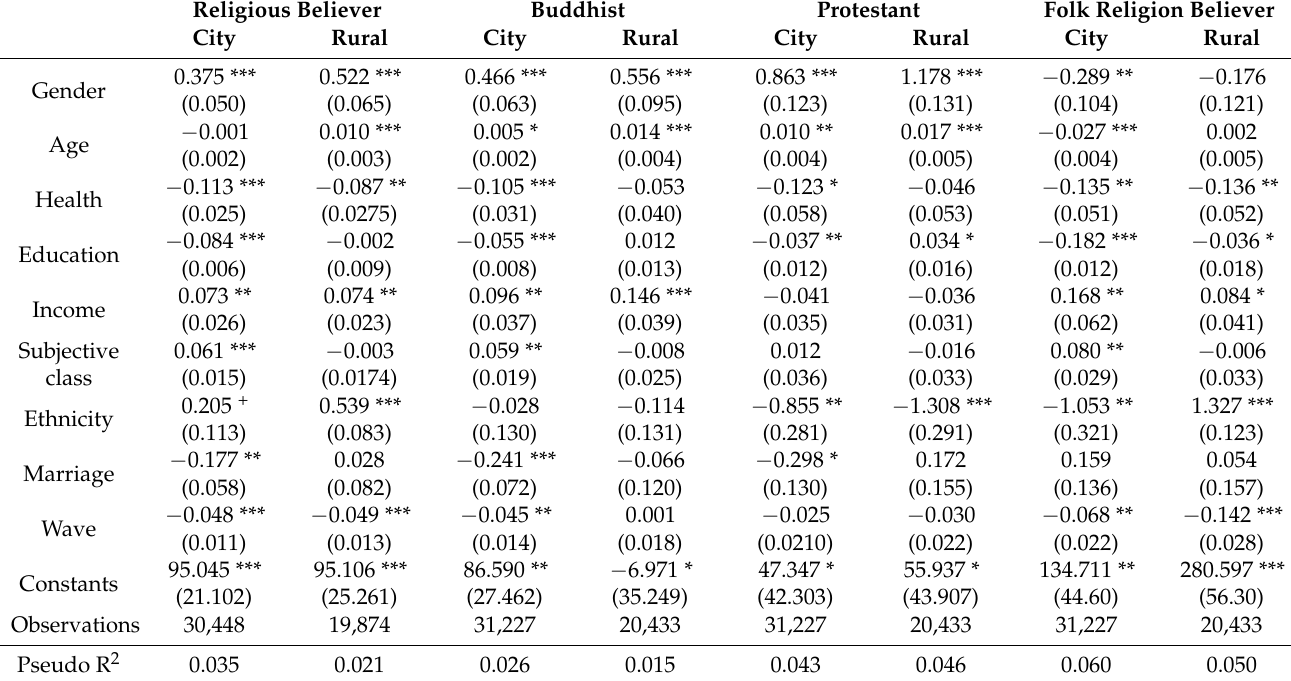
Table 5. Binary logistic regression model of urban and rural